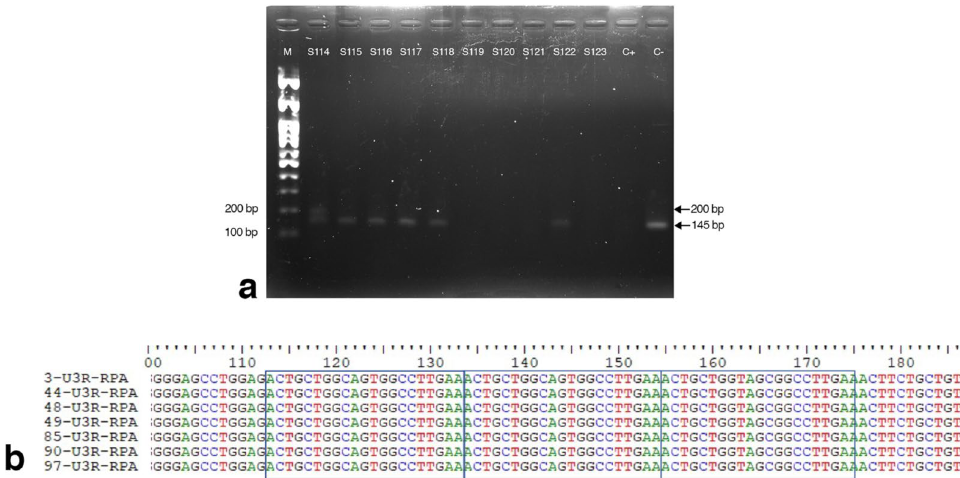
Figure 3. RT-RPA of clinical samples. ( a ) Representative image of agarose gel electrophoresis of RT-RPA products from clinical sample no. S114–S123. Legend: C+, positive DNA control; C−, no-template control; M,